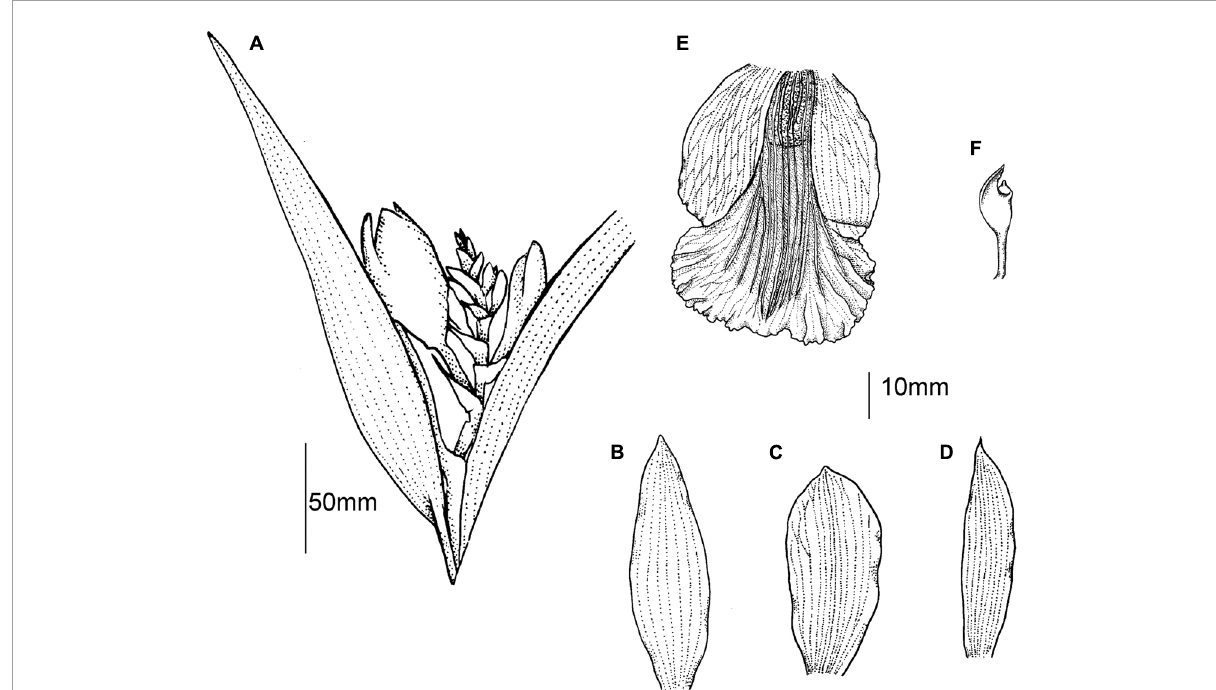
FIGURE3 Sobralia chrysoleuca Rchb. f. (A) apical part of stem with inflorescence, (B) dorsal sepal, (C) petal, (D) lateral sepal, (E) lip, and (F) gynostemium (drawn by P. Baranow from the holotype).